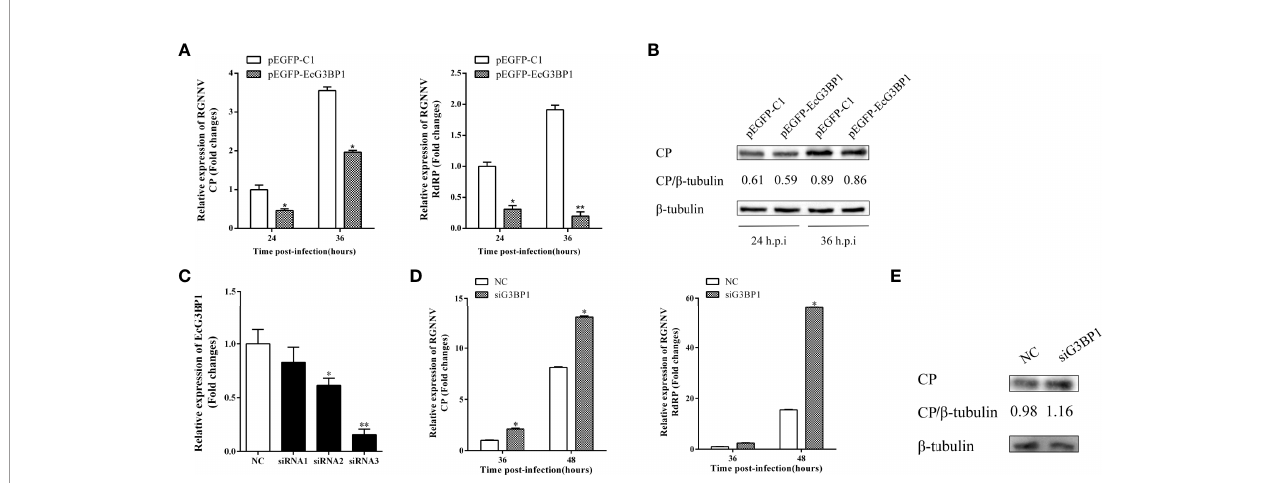
FIGURE 6 | Effect of EcG3BP1 on replication of RGNNV virus. (A) EcG3BP1 overexpressing cells were infected with RGNNV. GS cells were collected at 24 and 36 h post-infection, and the relative expression of RGNNV viral genes was examined using qRT-PCR. (B) EcG3BP1 was overexpressed in GS cells and infected with RGNNV 24h later. GS cells were collected and the expression level of CP protein was detected by western blot. (C) The NC siRNA or three siRNAs targeting EcG3BP1 were transfected into GS cells. The transcription levels of EcG3BP1 were determined at 48 h post-transfection by qRT-PCR. (D) GS cells were transfected with NC or siRNAs targeting EcG3BP1. At 48 h post-transfection, GS cells were infected with RGNNV and then collected to measure expression of CP and RdRp of RGNNV. (E) The CP protein of RGNNV was detected in transfected cells by western blot. b -tubulin was used as the internal reference. *p < 0.05, **p < 0.01.